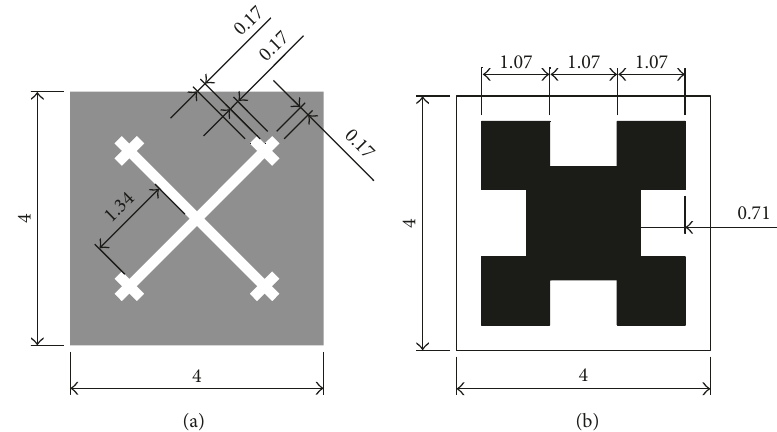
Figure 2: The fractal based elementary unit cells: (a) crossbar fractal for the top of the antenna, (b) Minkowski fractal for the bottom of the antenna (dimensions are in mm).